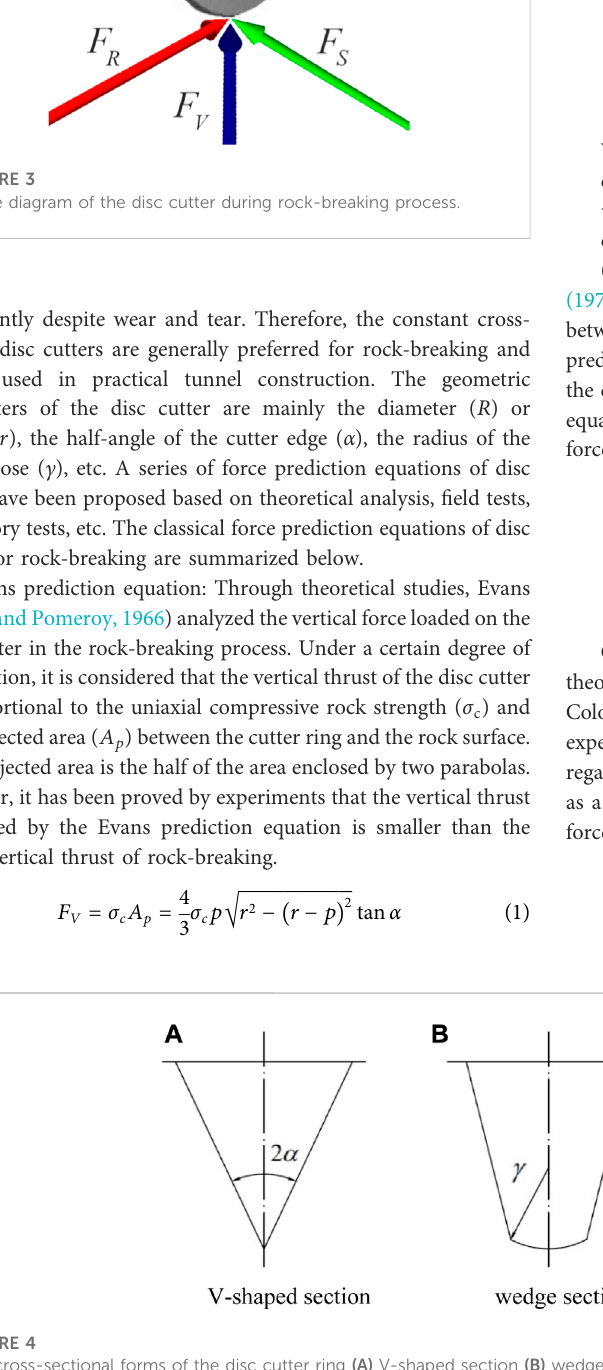
Frontiers in Earth